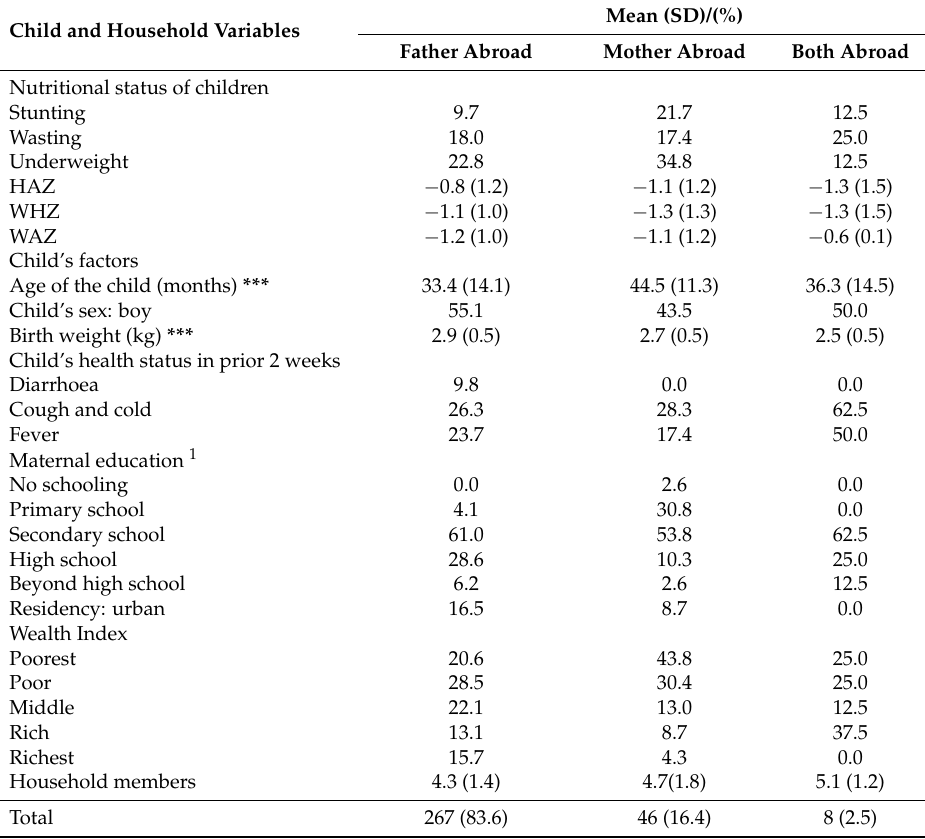
Table 2. Association of child and household variables by the migrant status of the parents 1 . Child and Household Variables